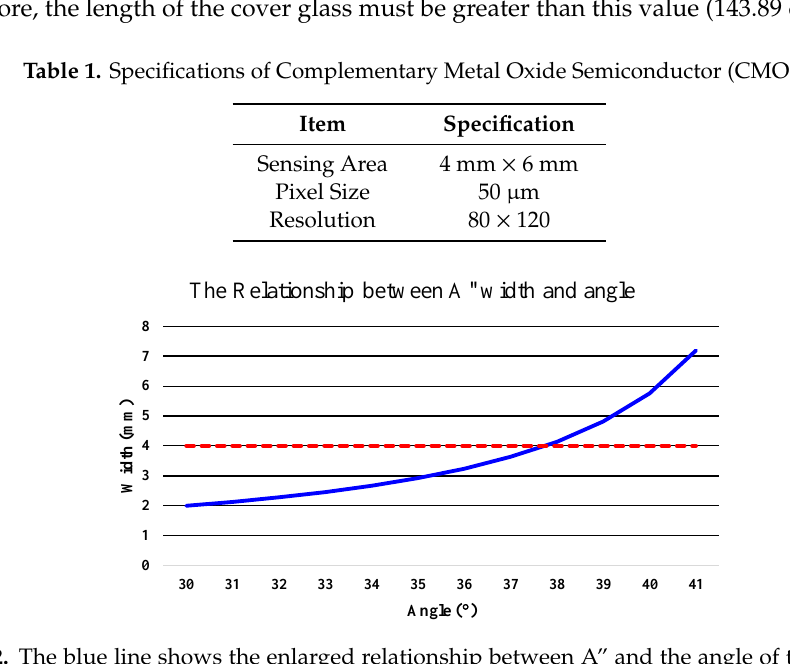
Figure 1. ( a ) The design concept which combines with the display panel. (b) Light area enlarges from A to A’ due to θ angle. (c) Light area enlarges from A’ to A’’ due to θ angle.